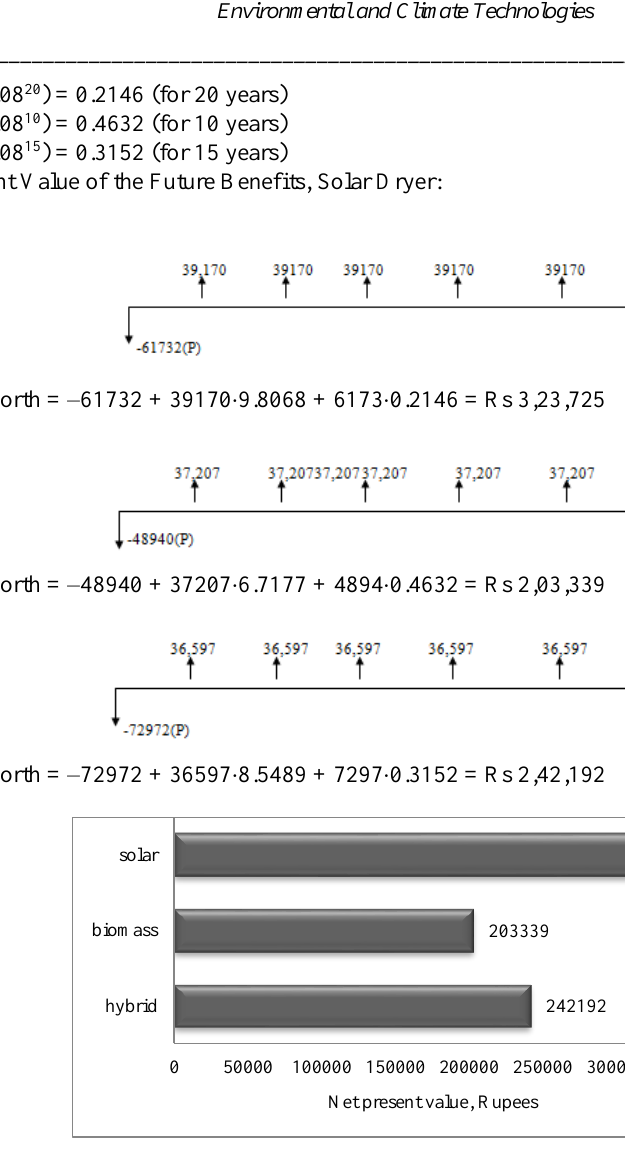
Fig. 3. Project benefit using net present